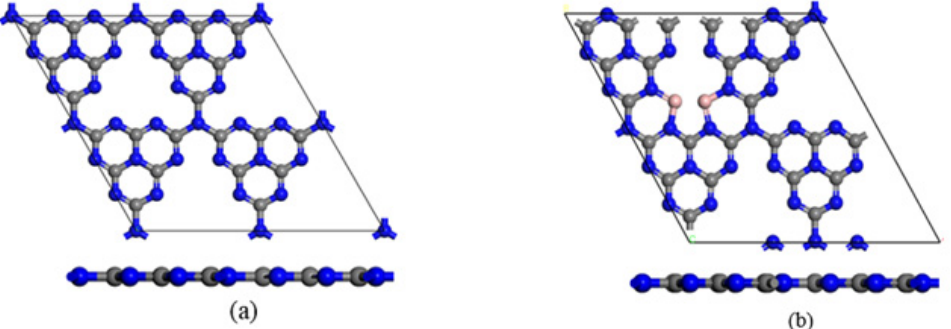
Figure 2. ( a ) Top view of optimized structures of N 2 adsorption on B2@C 3 N 4 and ( b ) side view of optimized structures of N 2 adsorption B2@C 3 N 4 for configurations, respectively.